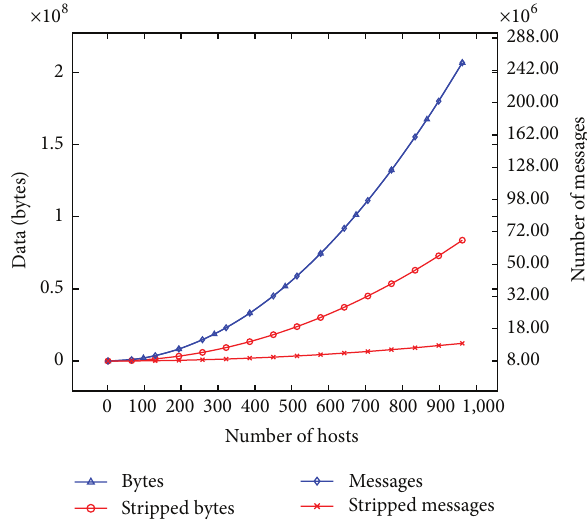
Figure 15: QoSiLAN signalling